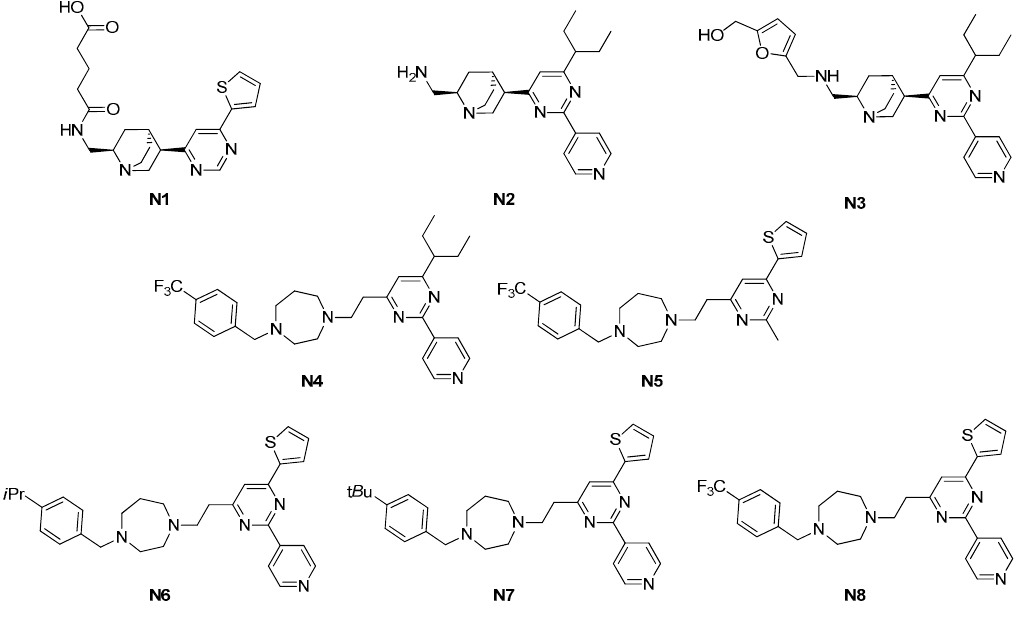
Figure 3. Pyrimidine FtsZ inhibitors.